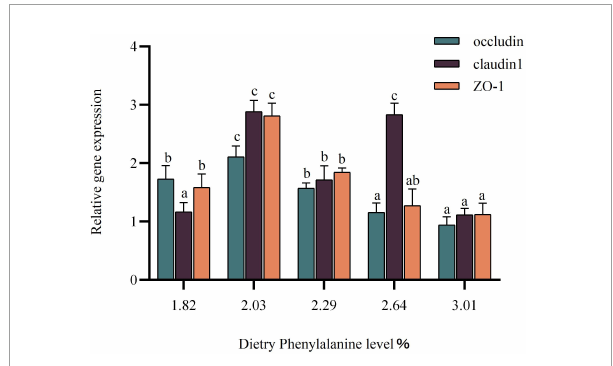
FIGURE6 Tight junction protein gene expression of the intestine. Lowercase letters (a, b, or c) indicate significant effects of intestinal tight junction proteins relative to gene expression ( p <